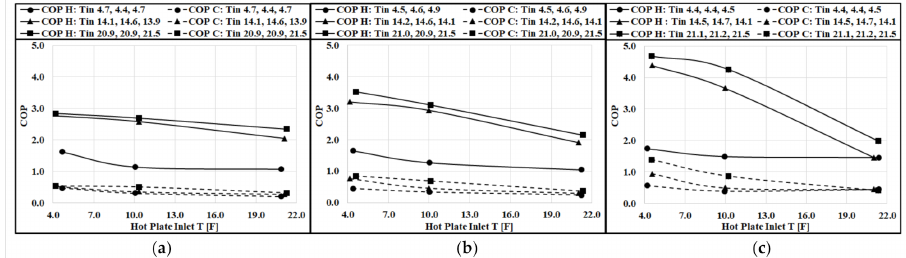
Figure 8. Hot panel inlet water temperature and COPs: ( a ) power demand: 266 W; ( b ) power demand: 120 W; ( c ) power demand: 54